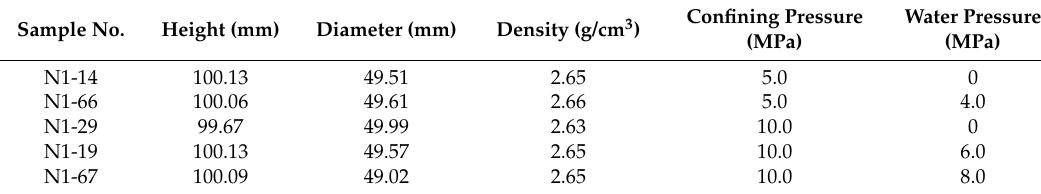
Table 1. Design for the tests under fixed confinements but altering water pressures. Sample No.